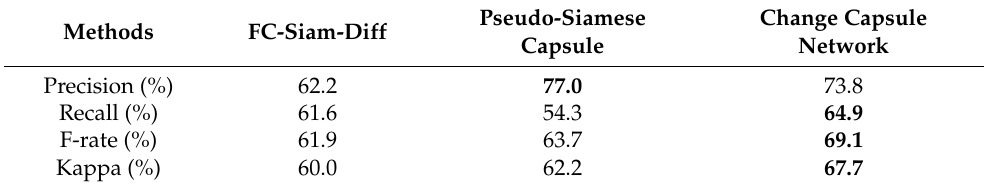
Table 6. Experimental results compared with other methods on the AUAB dataset.